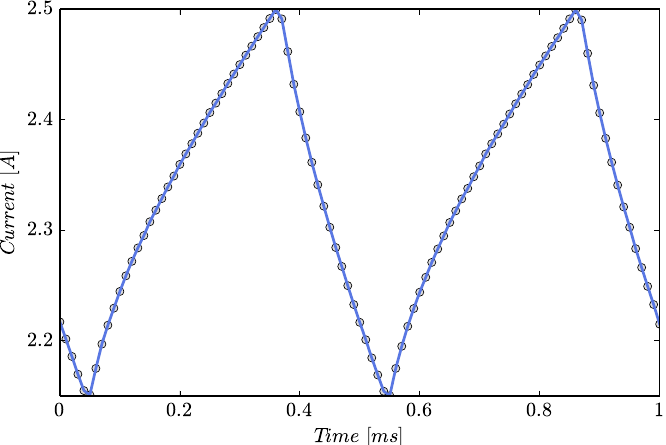
Figure 6. The 100kHz unfiltered current measurement used for estimating the saturation behavior of the prototype electric